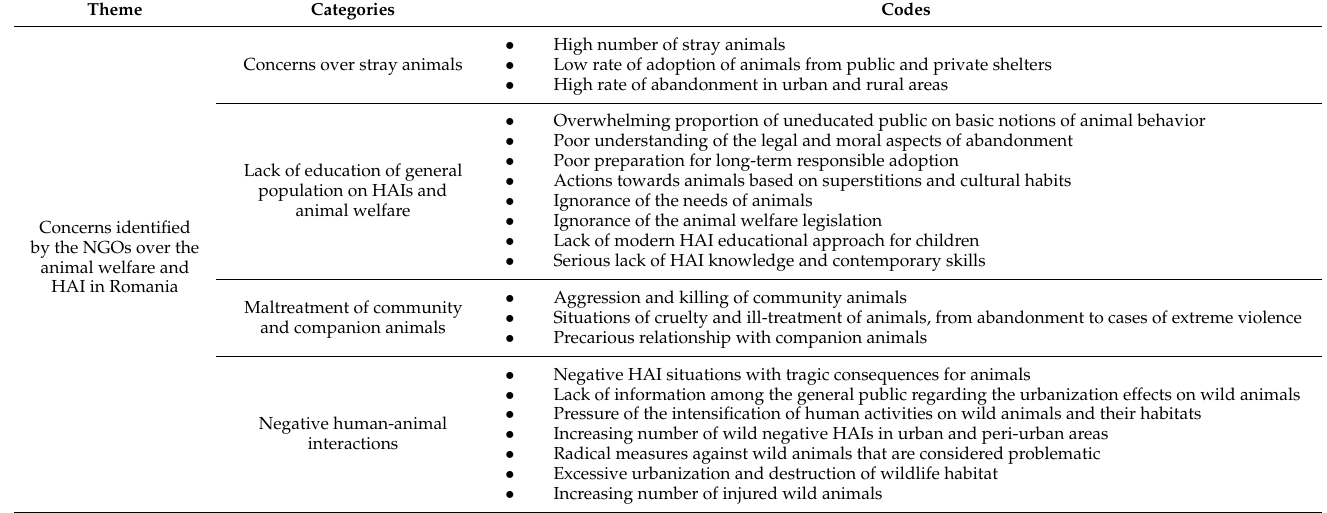
Table 1. Presentation of the categories and the codes corresponding to the theme “Concerns identified by the NGOs over animal welfare and HAIs (human-animal interactions) in Romania,” which were identified in the course of content analysis of the written reflections of the representatives of the six NGOs participating in the